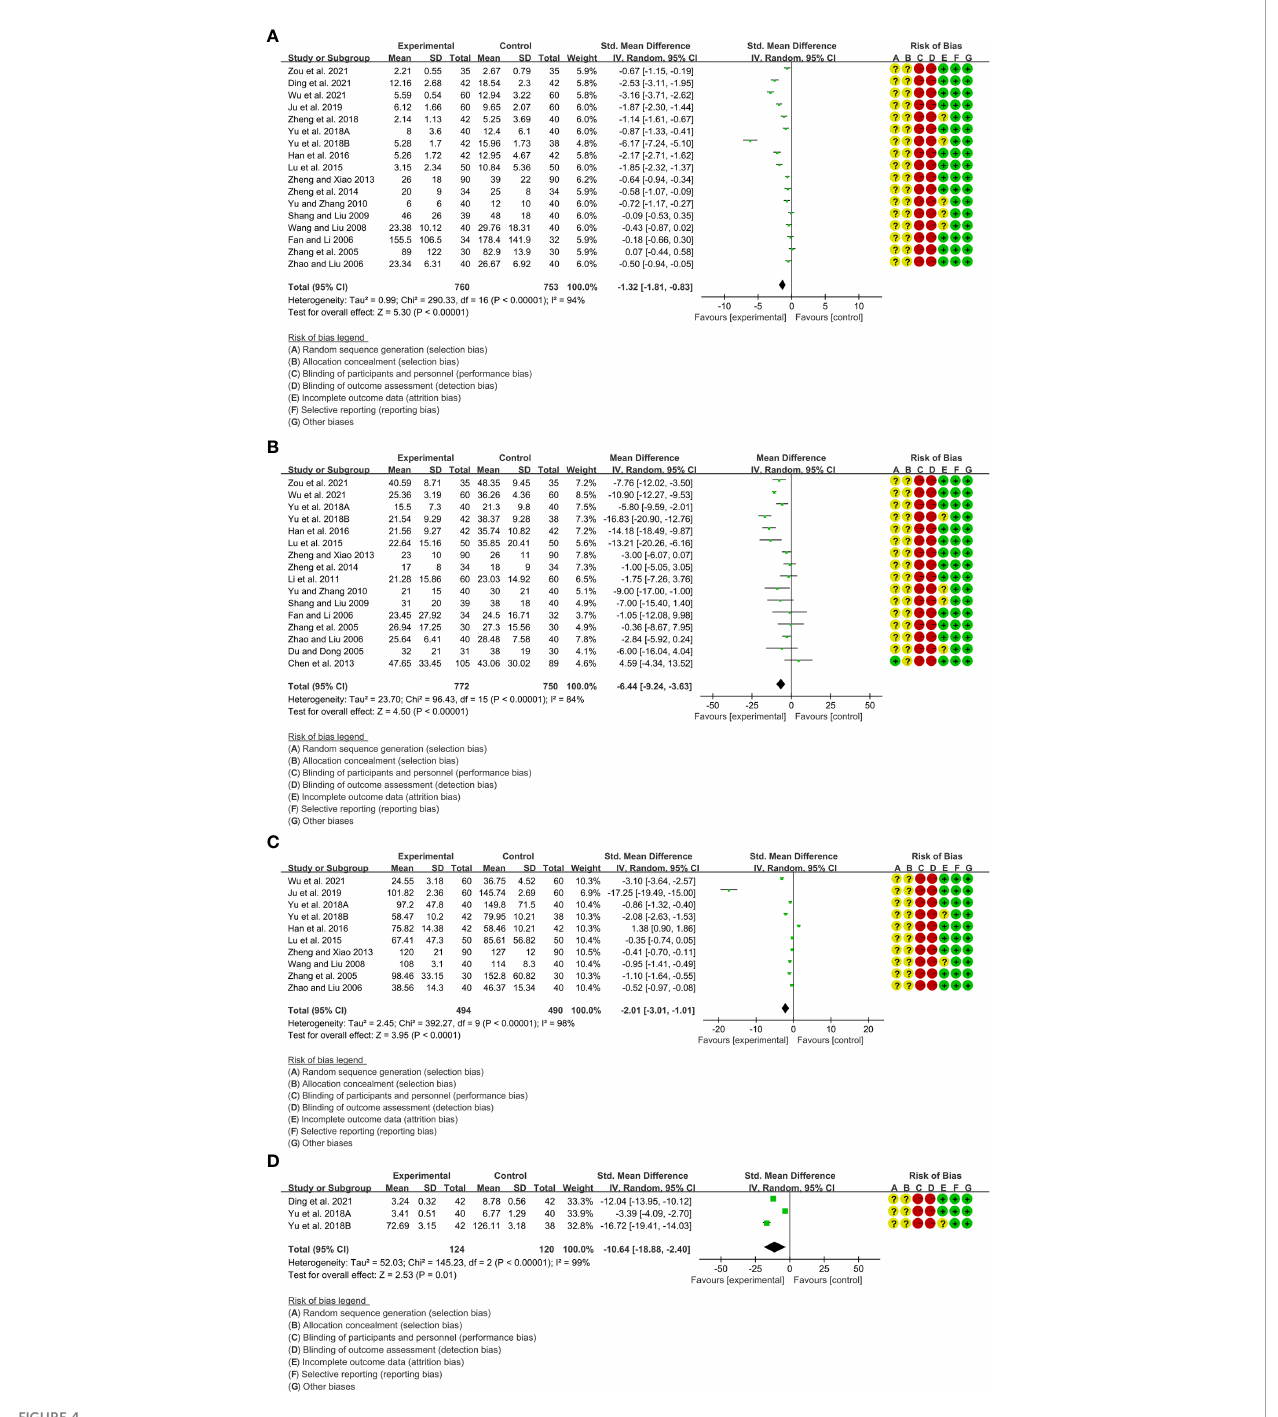
FIGURE 4 In fl ammatory parameters of Total glucosides of paeony (A) CRP; (B) ESR; (C) RF; (D)